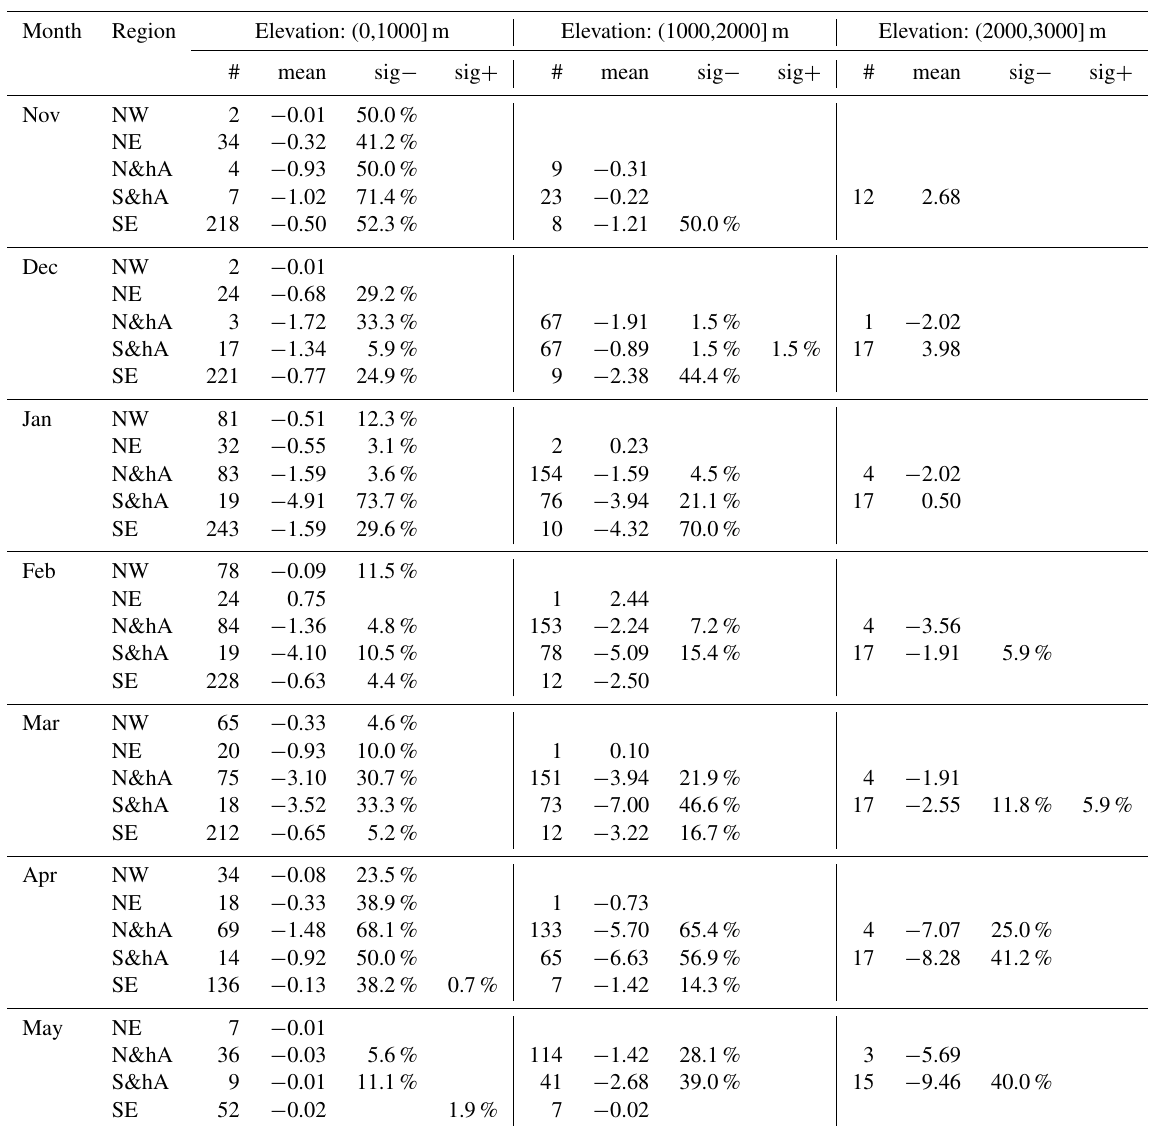
Table 2. Overview of long-term (1971 to 2019) trends in mean monthly snow depth. Summaries are shown by month, region, and 1000m elevation bands (0 to 1000, 1000 to 2000, and 2000 to 3000m). Cell values are the number of stations (#), the mean trend (mean, in centimetres per decade), and percentages of significant negative (sig − ) and positive (sig + ) trends; the remaining percentage (not shown) corresponds to the total of non-significant negative and positive trends. Empty cells denote no station available (for # and mean) and no stations with significant negative or positive trends (sig − and sig + ) . Trends were considered significant if p < 0.05. See also Fig. 7. A version of the table with 500m bands instead of 1000m is available in the Supplement (Table